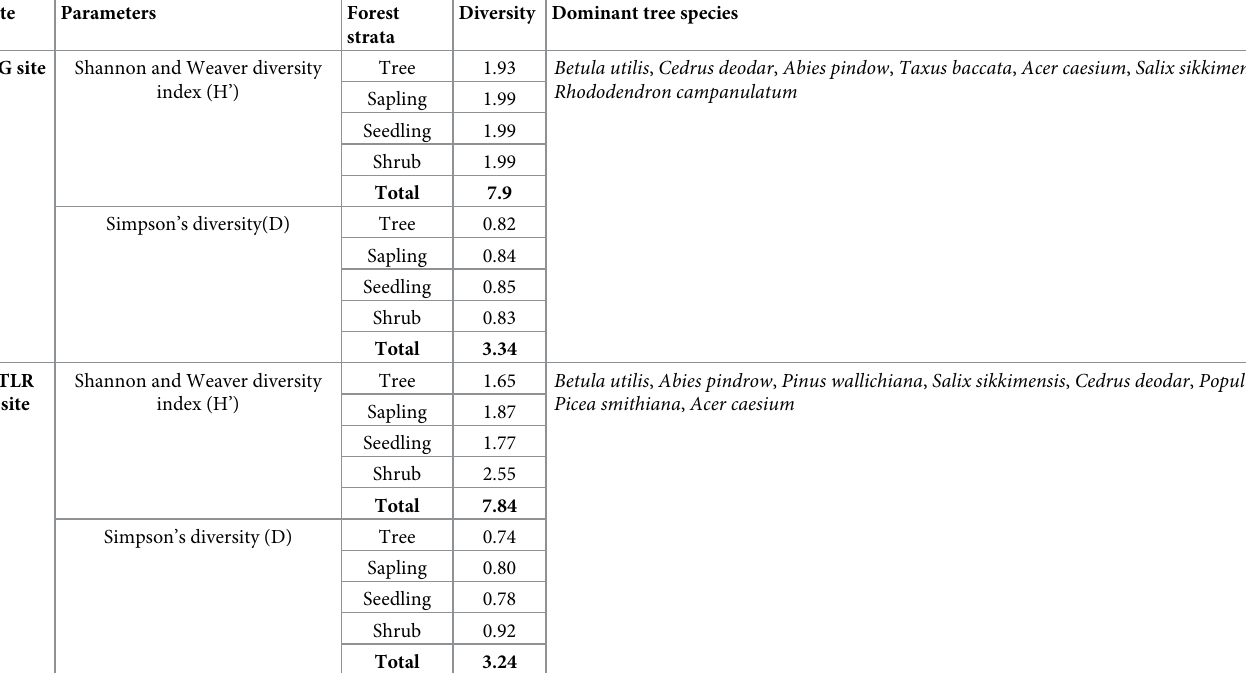
Table 1. Shannon and Weaver diversity index (H’) and Simpson’s diversity (D) for tree, sapling, seedling and shrub in BG and TLR sites. Site Parameters Forest Diversity Dominant tree strata